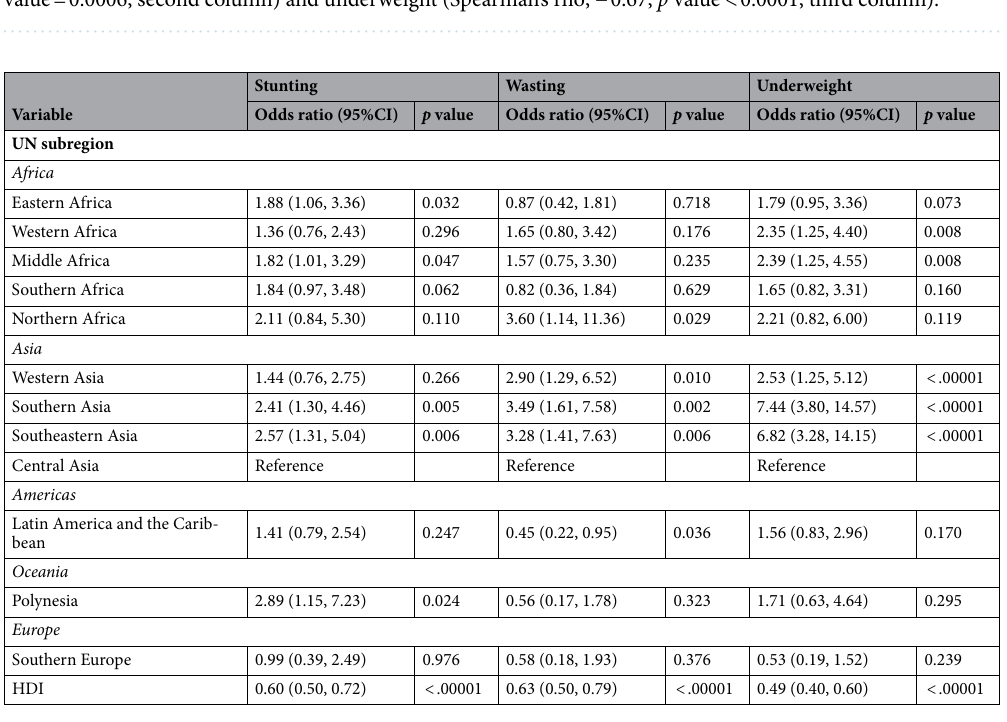
Figure 5. Correlation of HDI with undernutrition: A moderate negative correlation exists between HDI and stunting (Spearman’s rho; − 0.65, p value < 0.0001, first column), wasting (Spearman’s rho; − 0.43, p value = 0.0006, second column) and underweight (Spearman’s rho; − 0.67, p value < 0.0001, third column).